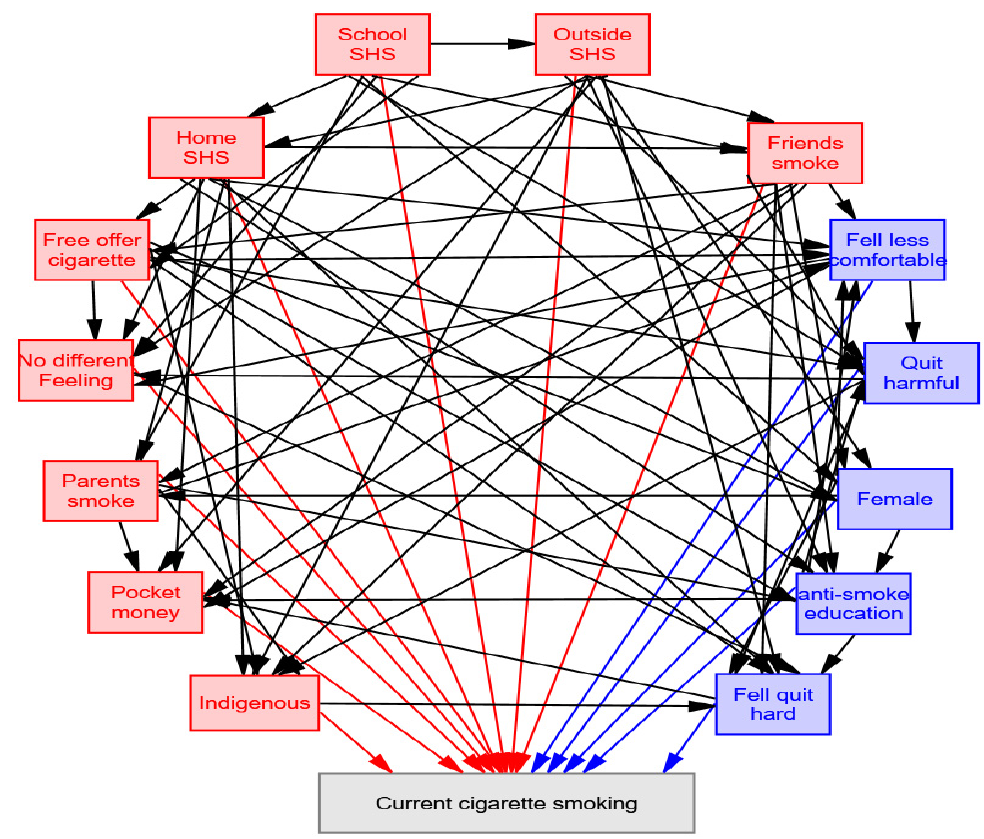
Figure 1. Final path analysis model for factors associated with current cigarette smoking. Table 3. Direct, indirect, and total effect of associated factors on current cigarette smoking incidence.